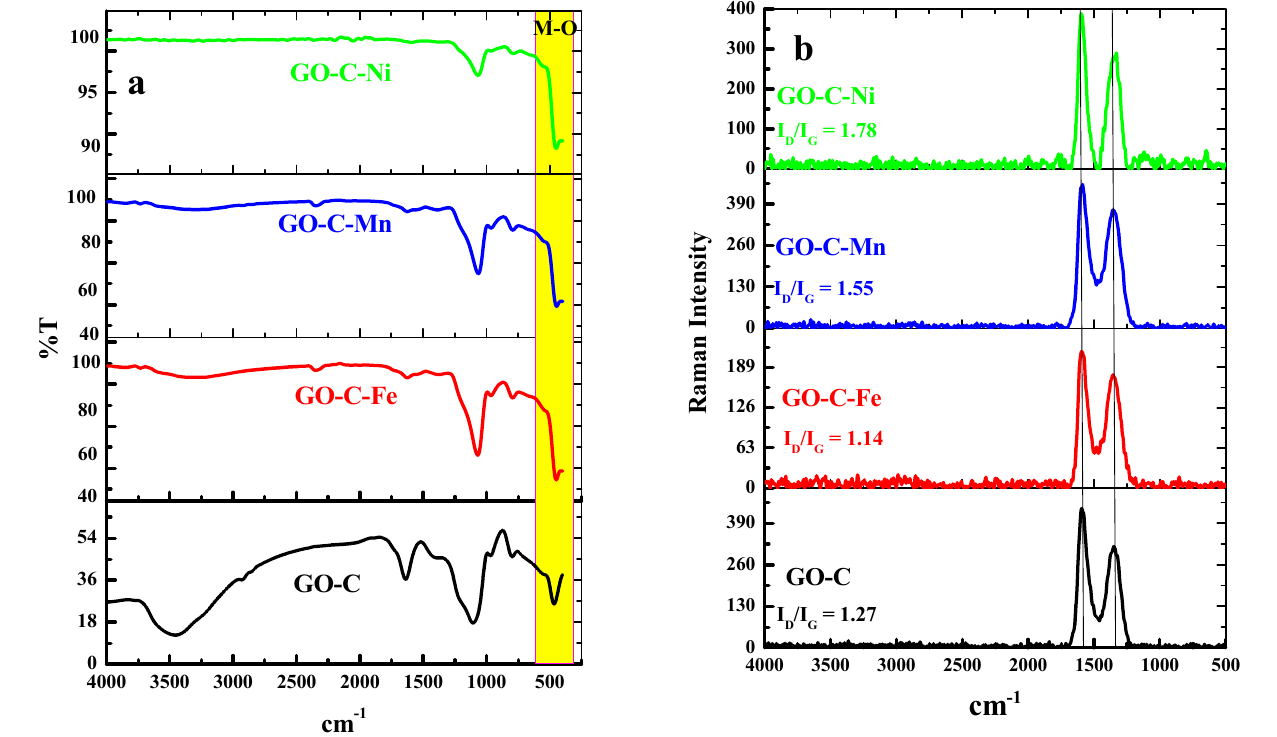
Figure 2. ( a ) FT-IR and ( b ) Raman spectra for GO-C composite, GO-C-Fe complex, GO-C-Mn complex, and GO-C-Ni complex.